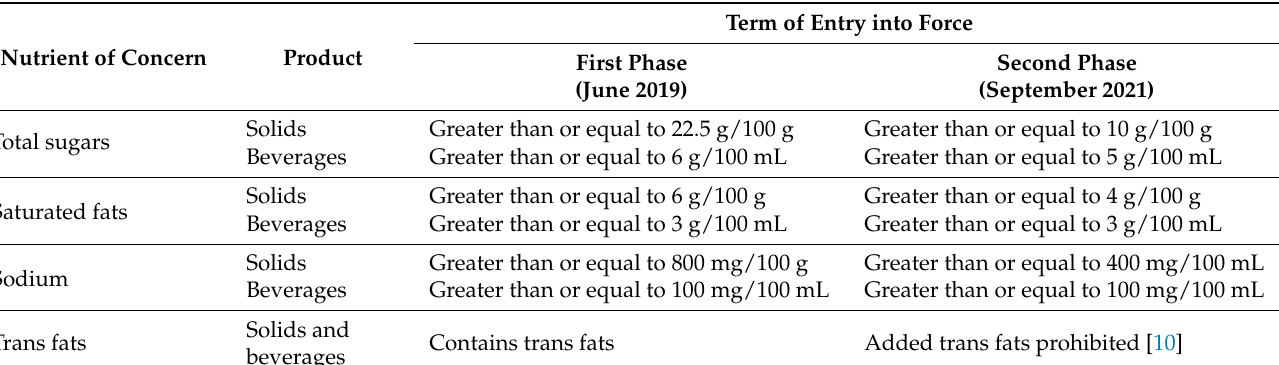
Table 1. Technical parameters and entry into force of the Promotion of Healthy Eating for Children and Adolescents